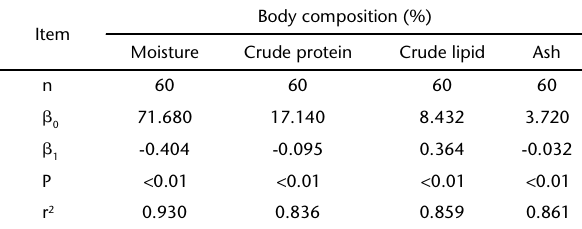
Table II. Statistical details showing number of fish studied (n), intercept (